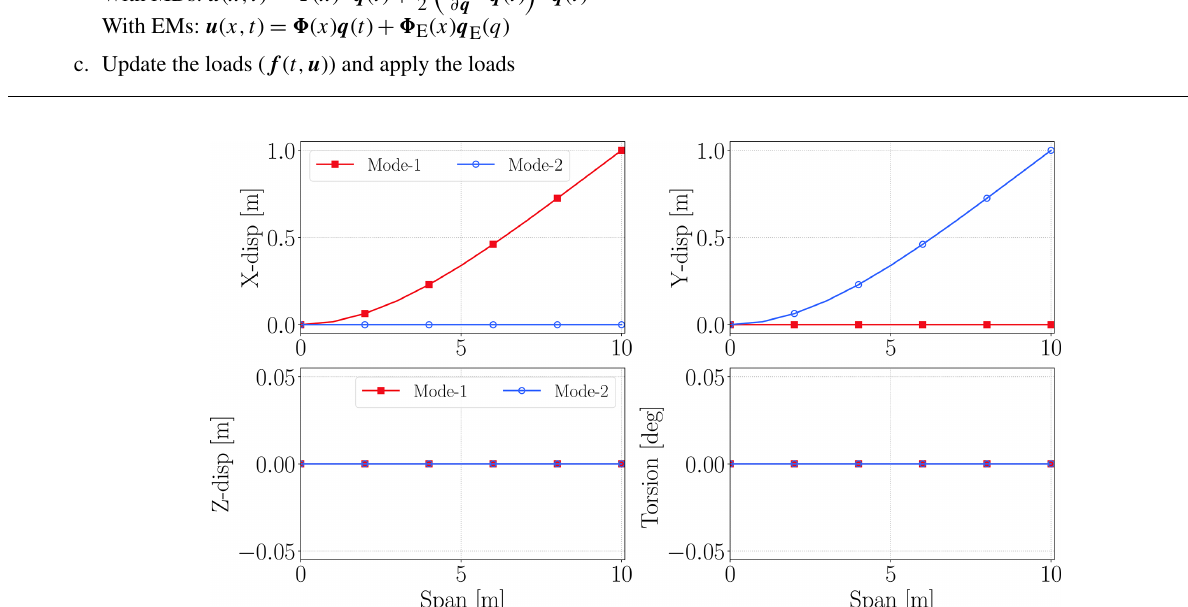
Figure 6. x , y , z and torsion components of first two mode shapes of straight beam. Beam span is along the z axis. z direction and 100 % error for all solutions. Modal deriva- tive and expansion mode errors are increasing by deflections and are much larger than bending ( x ) direction errors. The two main sources of error in the secondary ( z ) direction are truncation errors coming from Eq. (2) and the error in the